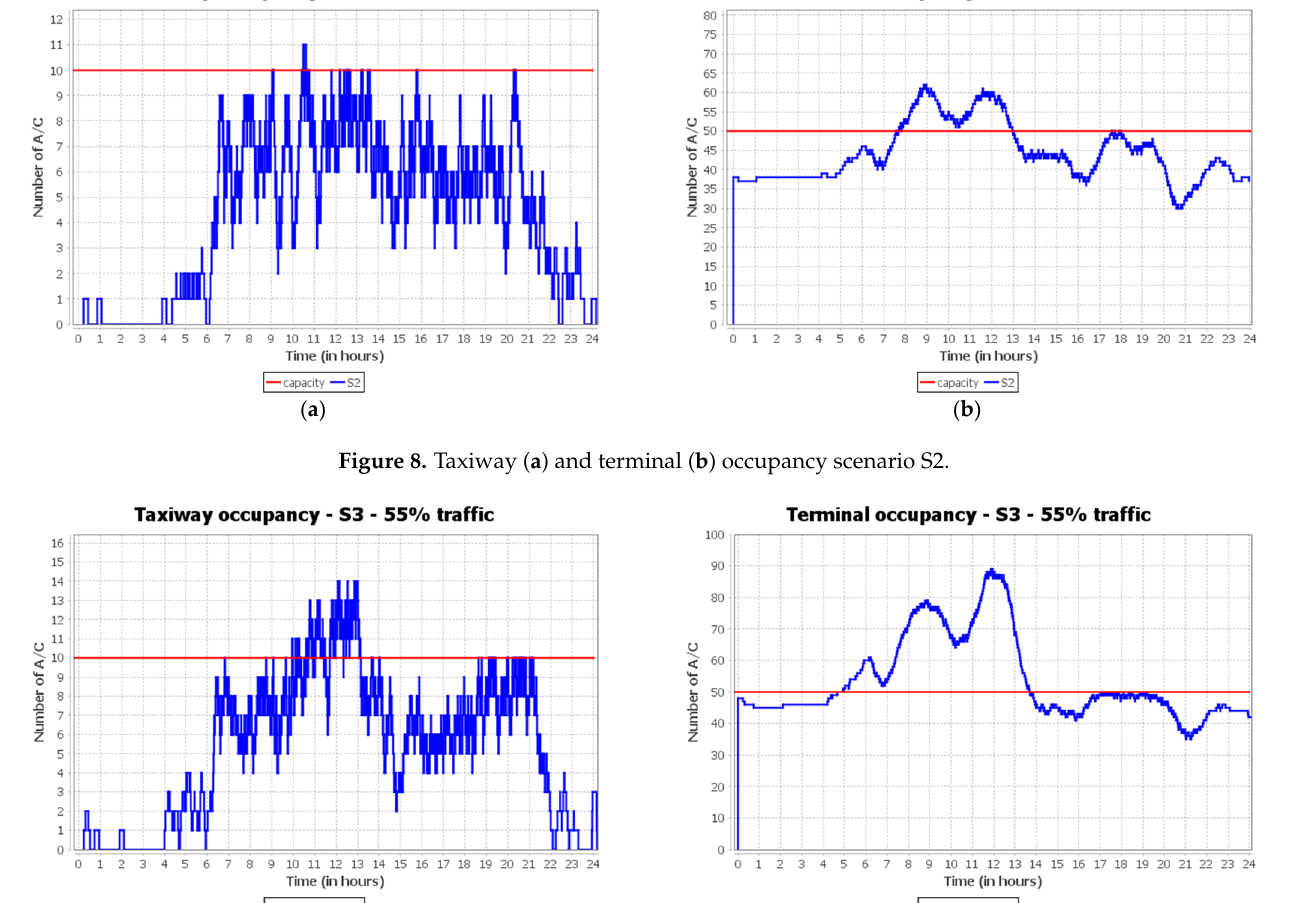
Figure 7. Taxiway ( a ) and terminal ( b ) occupancy scenario S1.